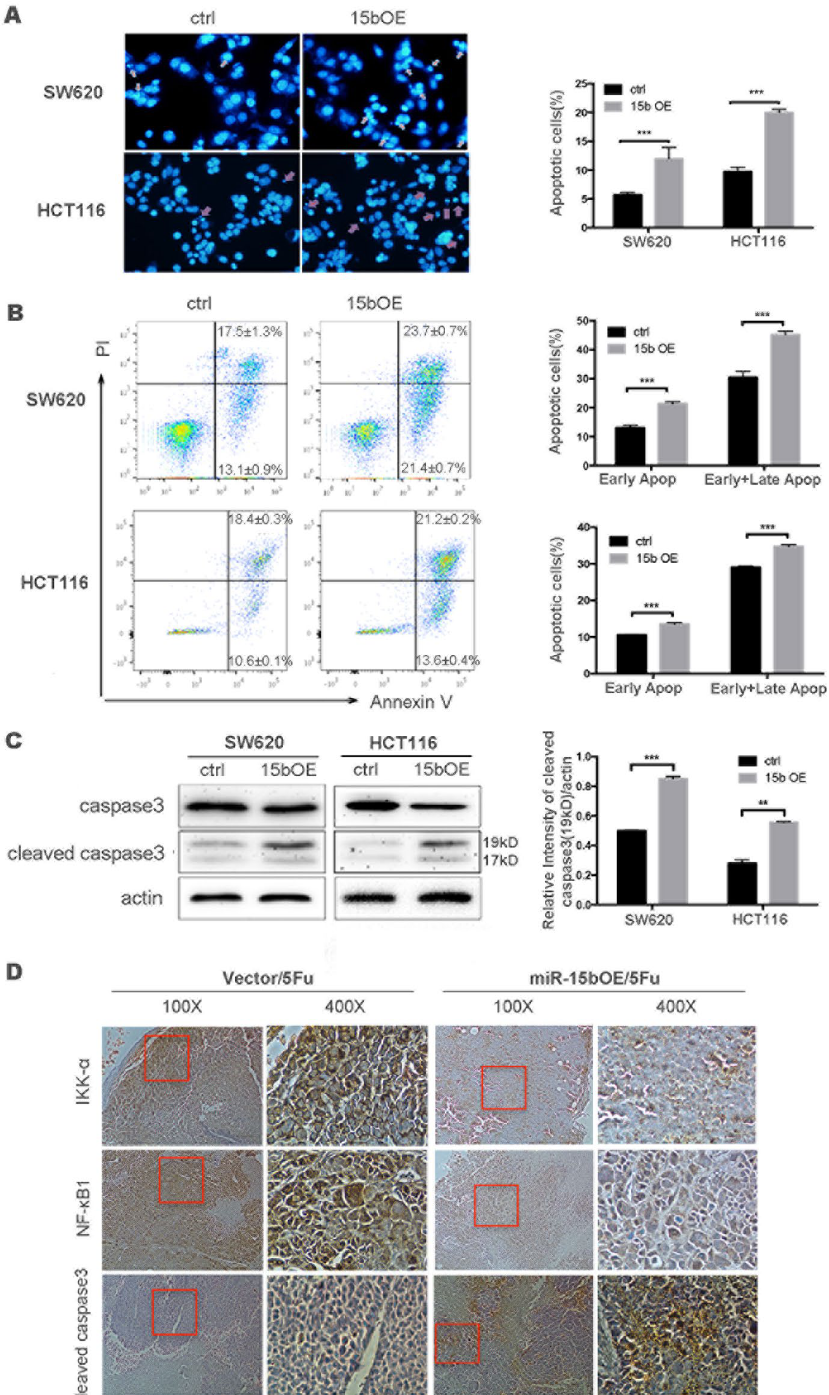
Figure 3. Overexpression of miR-15b-5p promotes apoptosis induced by 5-FU. ( A ) Apoptosis was analyzed by DAPI staining, after 5-FU-induced miR-15bOE and control cells shown representative image of apoptotic cells; and counting the percentage of apoptotic cells; Red marker pointed the apoptotic cell. ( B ) Flow cytometry was used to evaluate PI/Annexin V staining. miR-15b-5p increased 5FU-induced apoptosis in SW620 or HCT116 cells. The percentage of cells in the early or early plus late apoptotic stage was increased in miR-15bOE cells compared with control cells after the cells were exposed to 5-FU for 48 h. ( C ) Cleaved caspase3 protein detected by western blotting. The levels of cleaved caspase3 increased in miR-15bOE cells treated with 5-FU. Semi-quantitative data from densitometric analysis of cleaved caspase3 are presented as the relative ratio of each protein to actin ( * p < 0.05, ** p < 0.01, *** p < 0.001). ( D ) Representative images of the IHC examination of IKK- α , NF-ĸB1, and cleaved caspase3 in mouse tumors from miR-15b OE cells and vector mice after 5-FU